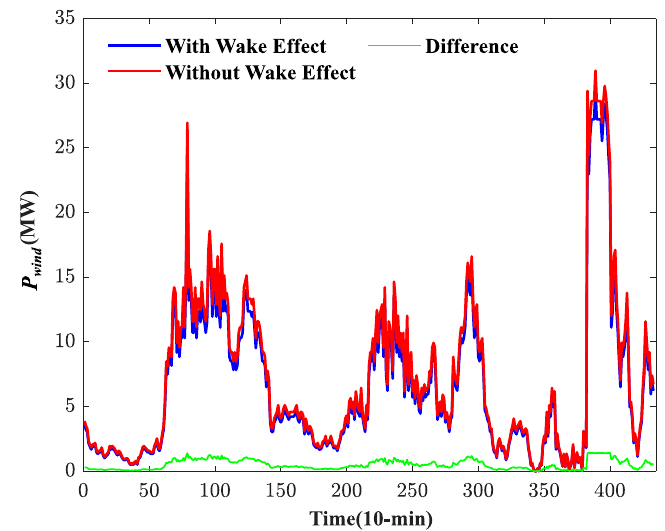
Figure 5. Power generated by the wind farm for three